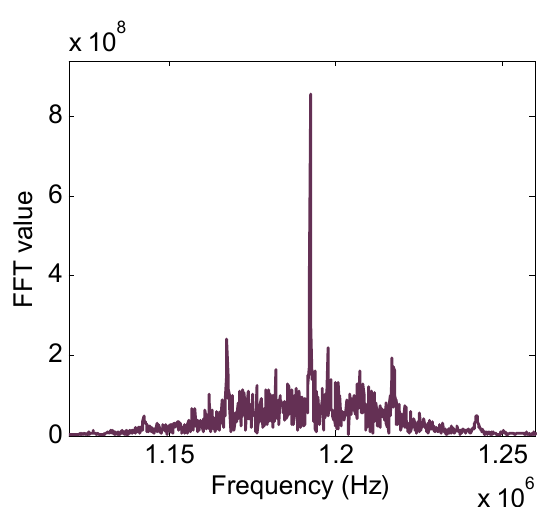
Figure 6. FFT results of the quadratic square IRIDIUM ring alert signal.